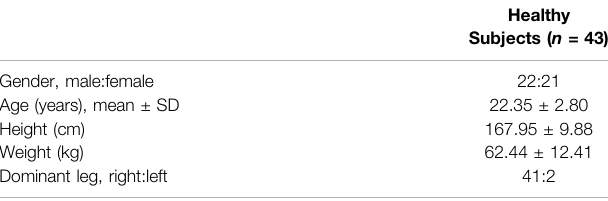
TABLE 1 | Demographic characteristics of all subjects.